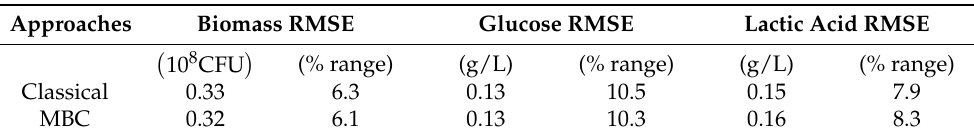
Table 3. Validation of the simulated data with respect to the actual offline data. Simulated biomass, glucose, and lactic acid were used to train the chemometric model and to perform the partial least square regression model.